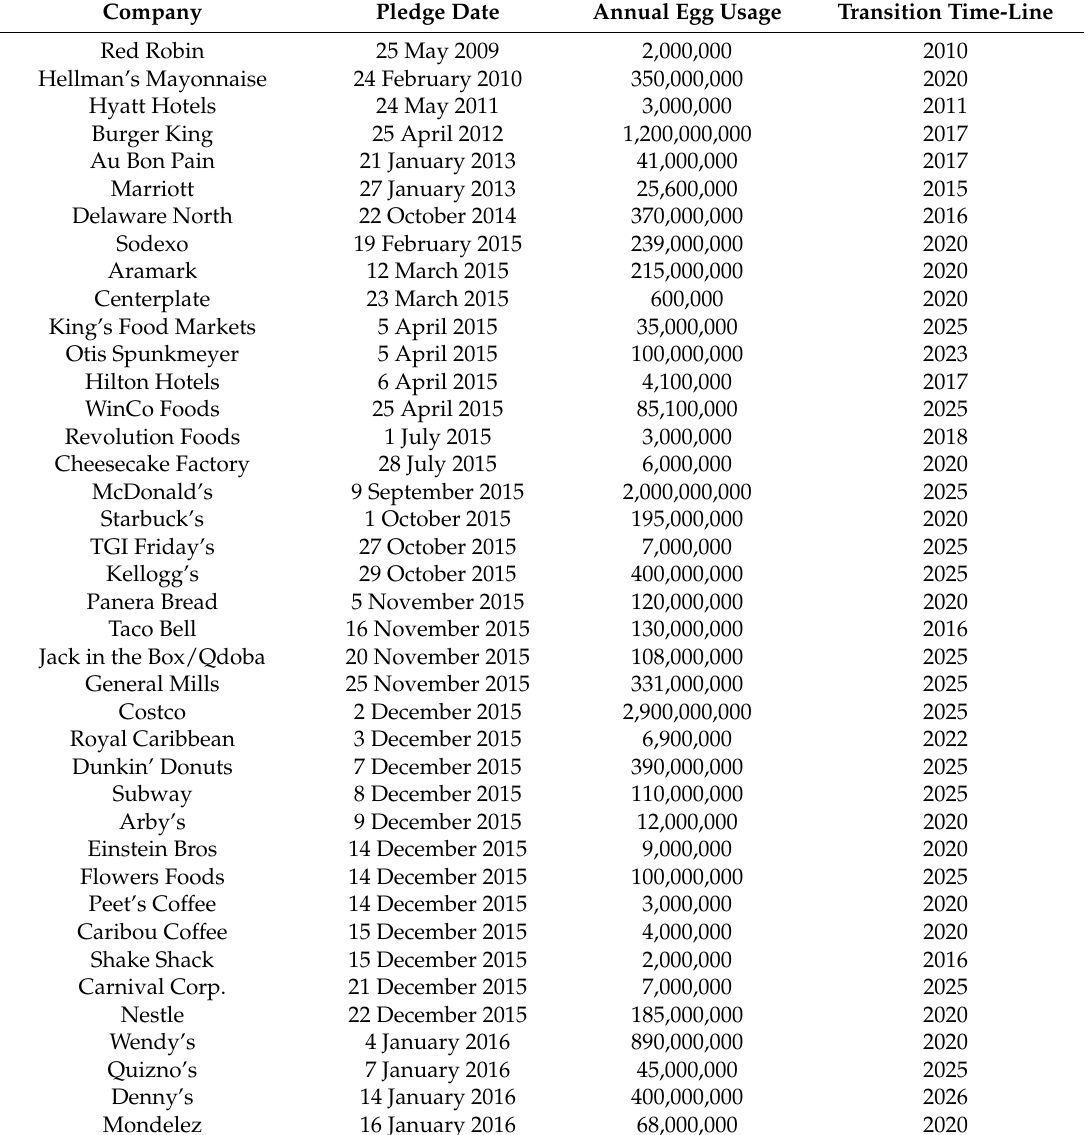
Table A1. A partial list of company cage-free pledges based on USDA estimates [83] and organized by the date of each public